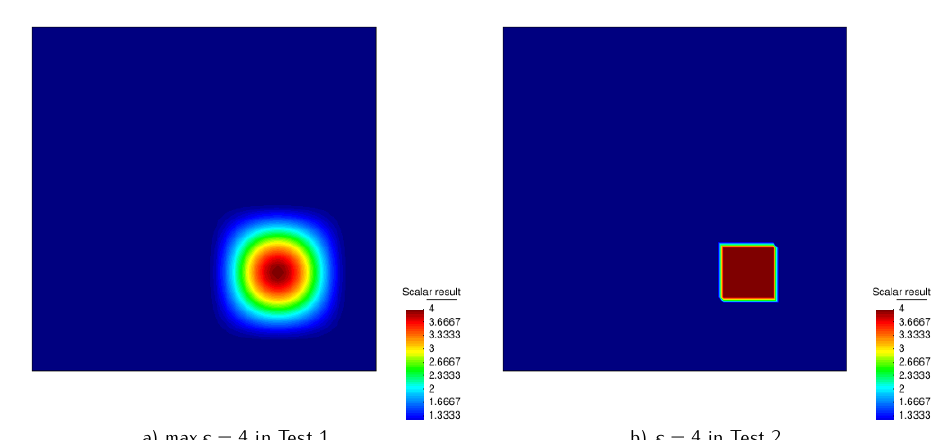
Figure 3. Coefficient ε